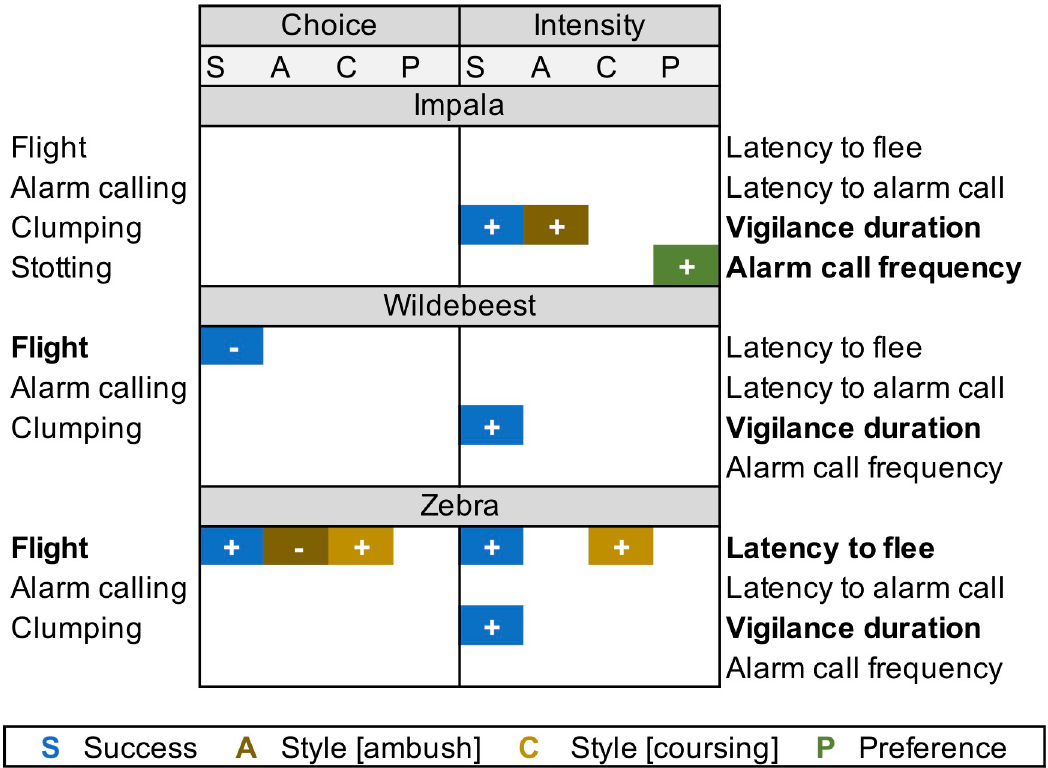
Fig 2. Anti-predator behavioral strategies adopted by focal prey species relative to predator traits. Impala relied on the same suite of behaviors, modulating the intensity of their response relative to multiple predator traits. Wildebeest altered the type and intensity of response, but only responded to predator capture success. Zebra adjusted both the type and intensity of behaviors performed in response to multiple characterizations of threat. Colored blocks correspond to predator traits that were strongly supported to affect response performance with +/- indicating the direction of the response. Relative predator density was never a significant driver of anti-predator tactics and is therefore